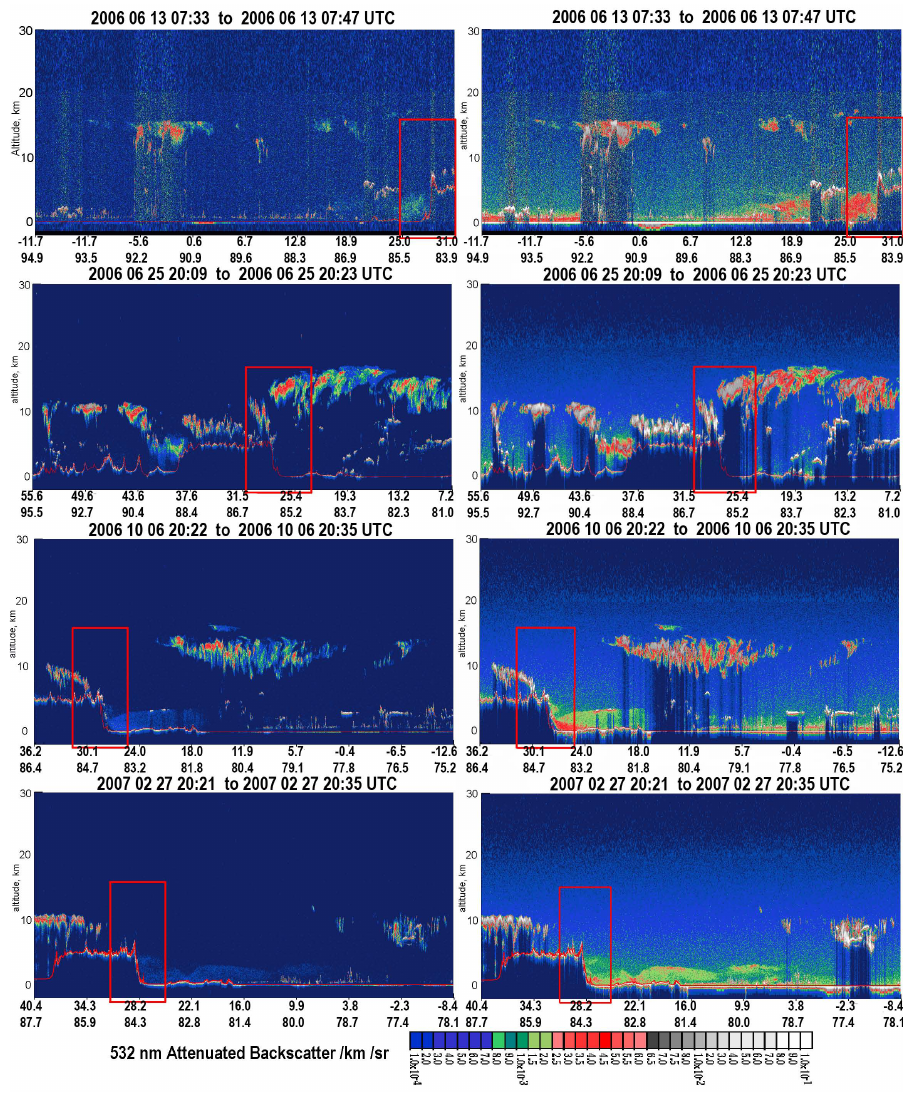
Fig. 7. CALIOP lidar transects across the Hymalayas on June 13, 2006 (a) , 25 June 2006 (b) , 6 October 2006 (c) , and 27 February 2007 (d) . The first lines of abscissa labels indicate the latitude, the second the longitude. Cross and parallel-polarized lidar returns (in terms of attenuated backscatter coefficients) are presented in the left and right columns, respectively. The Himalayan region of interest is evidenced by a red